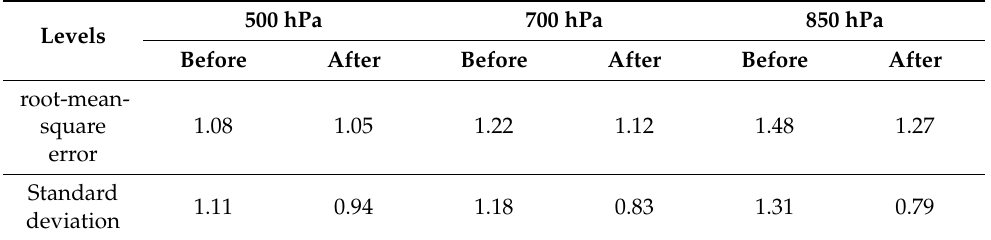
Table 4. RMSE and SD for 2017–2018 temperature measurements before and after correction. 500 hPa Levels Before After Before After Before